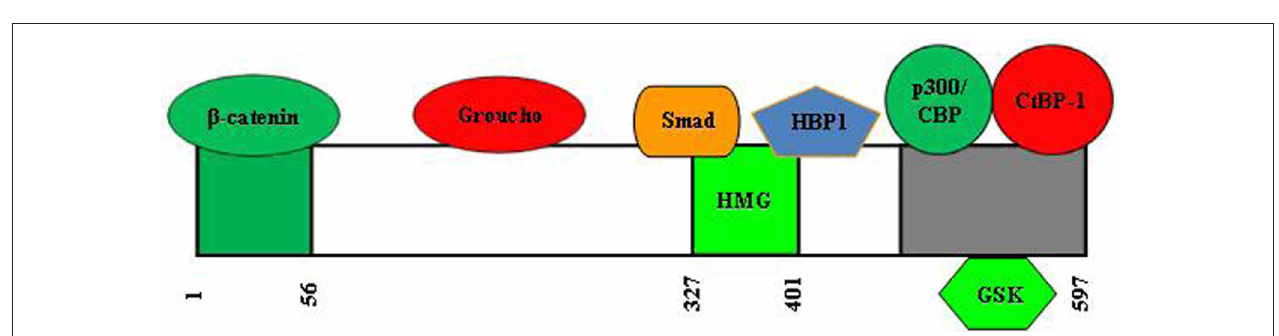
nucleus and forms the bipartite transcription factor β -cat/TCF, which leads to the stimulation of Wnt target gene expression. Lithium is an inhibitor of GSK-3, while cAMP signaling and insulin are able to stimulate β -cat Ser675 phosphorylation. Thus, in certain cell lineages, β -cat/TCF can also mediate the effect of lithium, cAMP, and insulin on Wnt target gene expression.